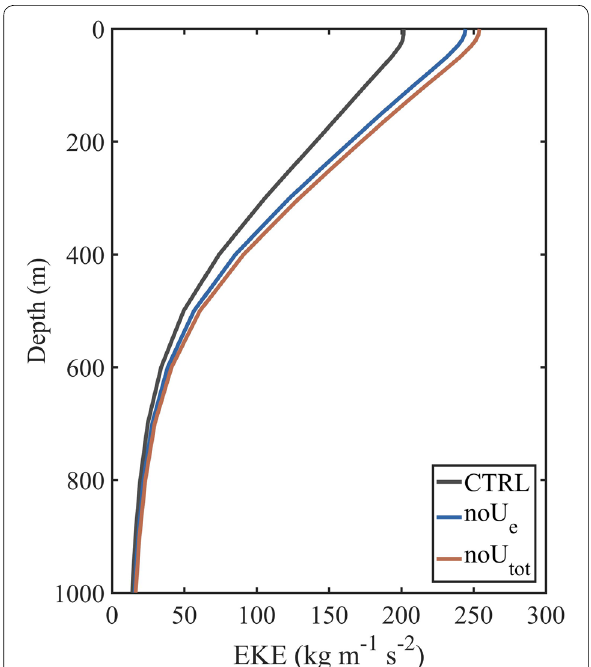
Fig. 2 The 5-year wintertime mean EKE averaged within the Kuroshio extension region in CTRL (black line), noU e (blue line) and noU tot (red